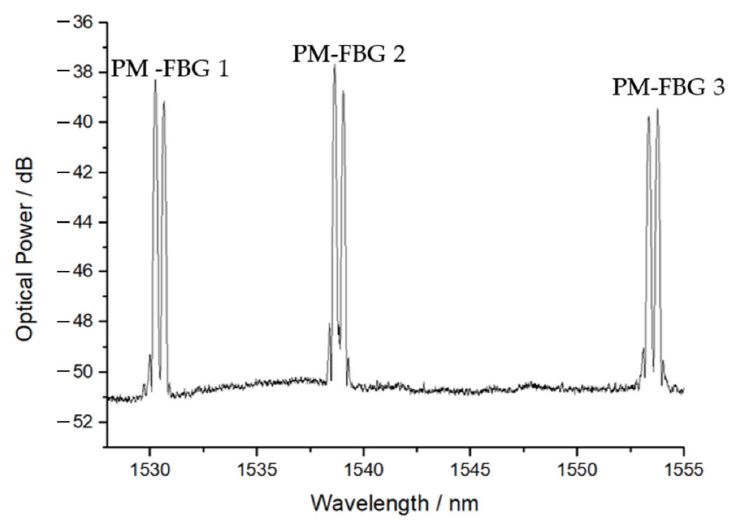
Figure 3. Spectrum response of the three PM ‐ FBG sensors inscribed in the same PM optical fiber; six peaks were acquired using the optical interrogator and the fast and slow peaks of each PM ‐ FBG sensor.